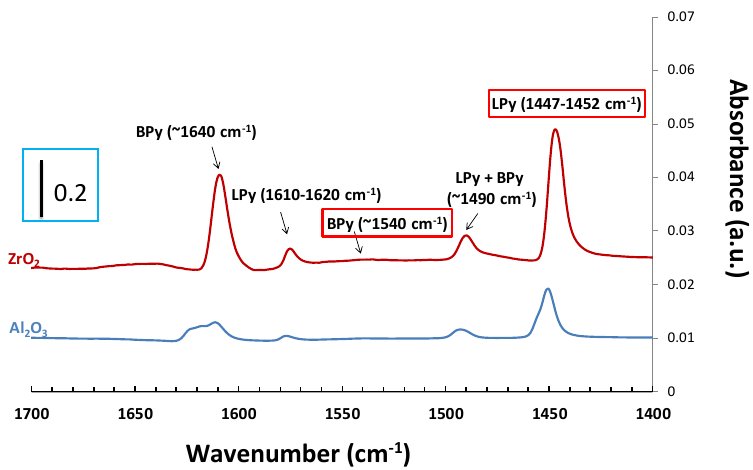
Figure 2. Infrared spectra of pyridine adsorbed on CoMo / Al 2 O 3 and CoMo / ZrO 2 .